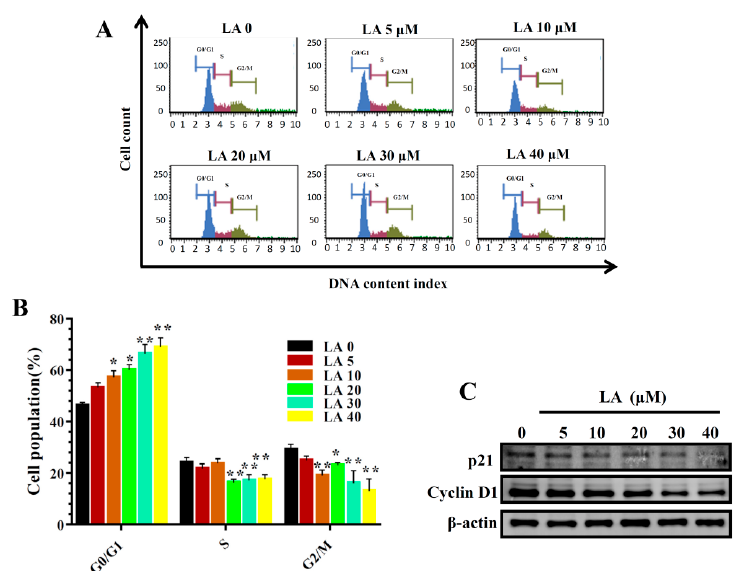
Figure 3. Effects of licochalcone A (LA) on cell cycle analysis. ( A ) Cells were seeded on a culture plate and treated with LA for 24 h. Cells were treated with MuseTM Cell Cycle reagent and the cell cycle status detected by flow cytometry. ( B ) Percentages of cells in each cell-cycle phase. The data are presented as mean ± SD of three independent experiments (n = 6). * p < 0.05, ** p < 0.01 compared to untreated cells (0 µ M LA). ( C ) p21 and cyclin D1 were assessed by Western blot, with β -actin as an internal control.